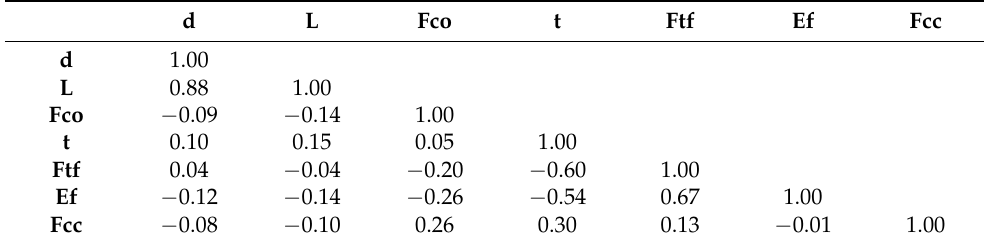
Table 2. Correlation coefficient